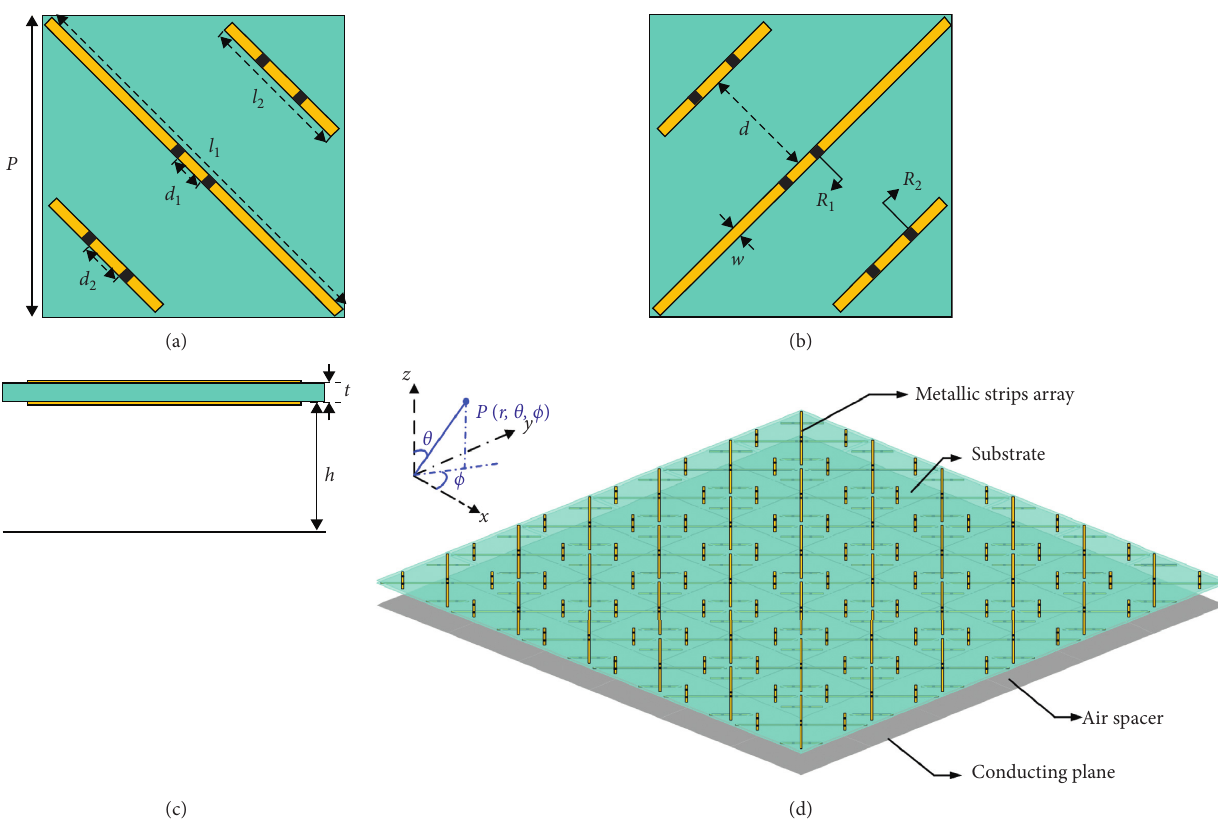
Figure 1: Configuration of the designed absorber. (a) Top surface of the substrate. (b) Bottom surface of the substrate. (c) Side view. (d) 3D � 27, l � 9 . 5, d � 1 . 5, d � 2 . 5, d � 8, w � 0 . 5, and t � 0 . 5 (all dimensions are in view. p � 20, h � 7 . 5, l 1 2 1 2